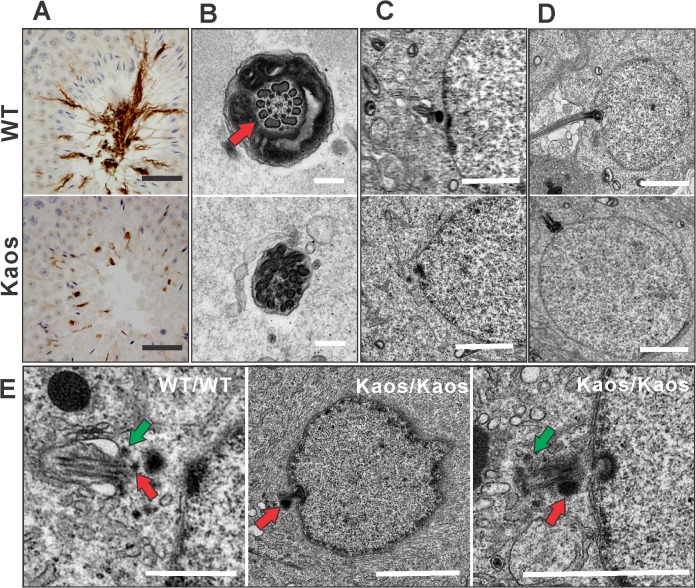
Axoneme defects in Lrguk
Kaos/Kaos mice.
(A) The staining of testis sections with the axoneme marker, acetylated tubulin, indicated an almost complete absence of axoneme development in Lrguk
Kaos/Kaos germ cells. (B) Transmission electron microscopy indicating the absence of axoneme development in wild type and Lrguk
Kaos/Kaos elongating spermatids. Red arrows indicate outer dense fibers. Scale bar = 0.2 μm. (C-D) Transmission electron microscopy of basal body docking to the plasma and nuclear membrane (C) and subsequent axoneme extension in Lrguk
WT/WT cells but the absence of plasma membrane attachment and axoneme of extension in Lrguk
Kaos/Kaos spermatids. Scale bar = 2 μm. (E) A closer examination of the early phases of basal body structure and movement revealed the presence of normal distal appendages (DAPs, green arrow)) and sub-distal appendages (SAPs, red arrow) in wild type cells associated with plasma membrane attachment. Lrguk
Kaos/Kaos germ cells contained enlarged SAP and the basal body failed to associate with the plasma membrane. The scale bar = 2μm.